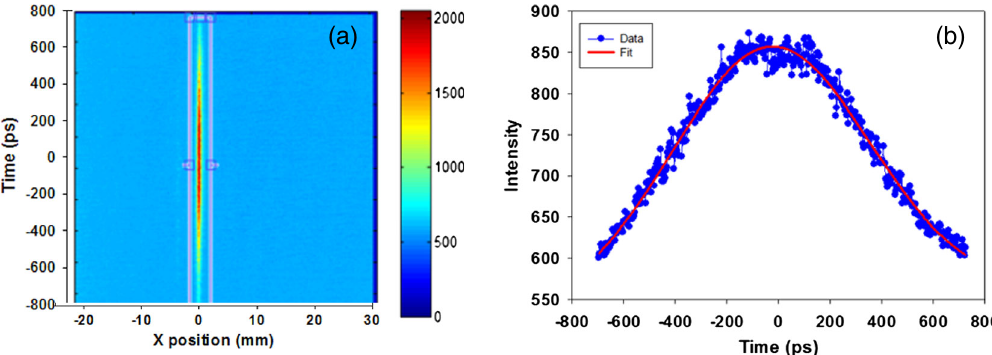
FIG. 7. (a) Streak camera range 4, ten-image sum and (b) time profile (blue) and single Gaussian profile fit (red) with a bunch length of 372 (cid:3) 12 ps at 0.32 nC and with the beam energy of 425 MeV. An intensity scale is given in the bar at the right of the image.